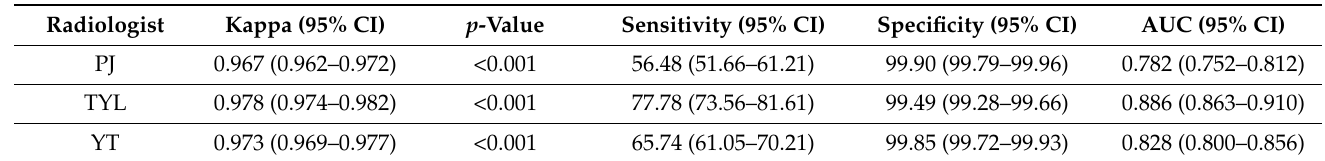
Table 6. Radiologist sensitivity, specificity, and AUCs for two-grade (normal/low versus high-grade) MESCC per CT image.